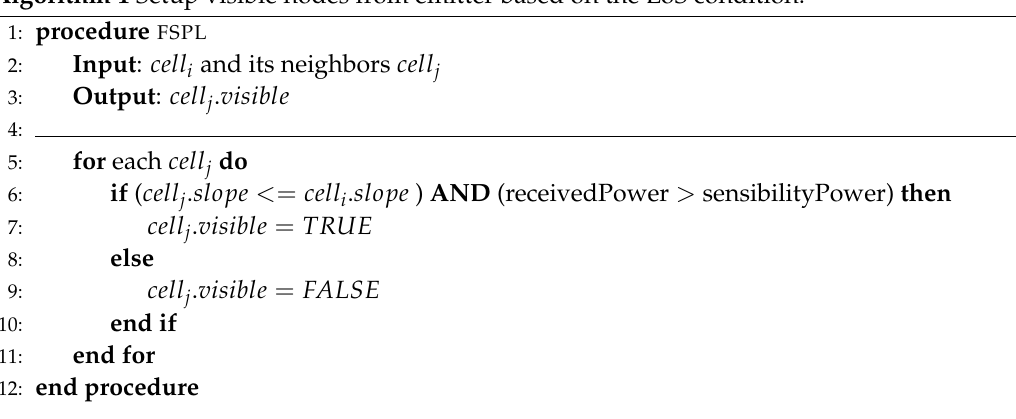
Figure 15. A profile obtained along a route. Let’s assume that an emitter located on the furthest left of the chart, with a distance of 0 m, an elevation of 350 m. According to LoS condition, three points at distances 2997 m, 3269 m and 3541 m seem unable to receive the signal from the emitter. Algorithm 1 Setup visible nodes from emitter based on the LoS